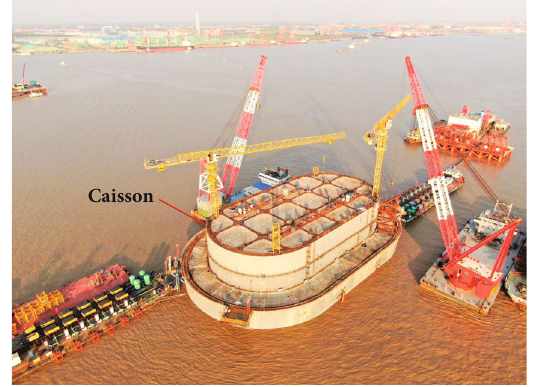
Figure 2: Caisson under